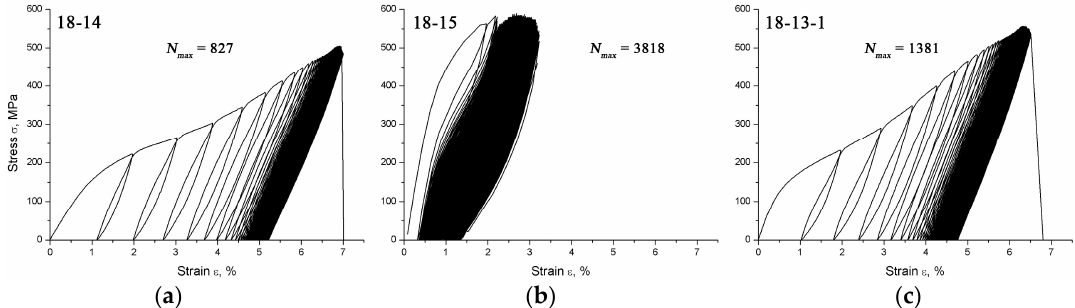
Figure 2. Typical sets of loading ‒ unloading diagrams obtained during multi-cycle testing of ( a ) 18-14, ( b ) 18-15, and ( c ) 18-13-1 alloys subjected to TMT.